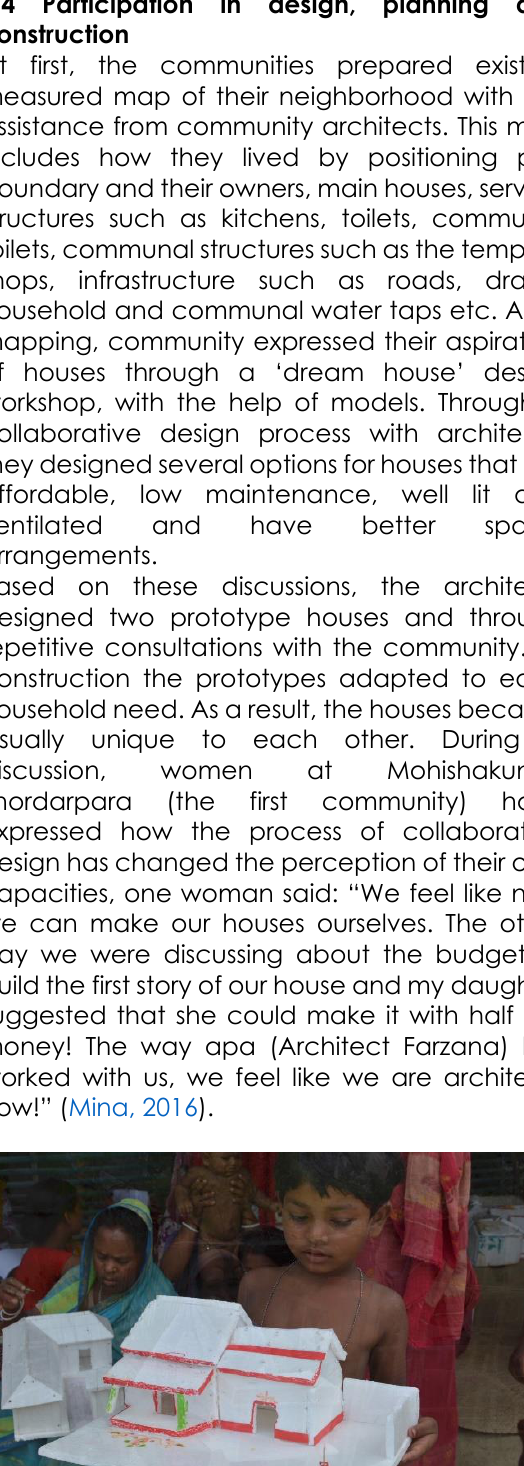
Figure 6: House designed at dream house design workshop (Co.creation